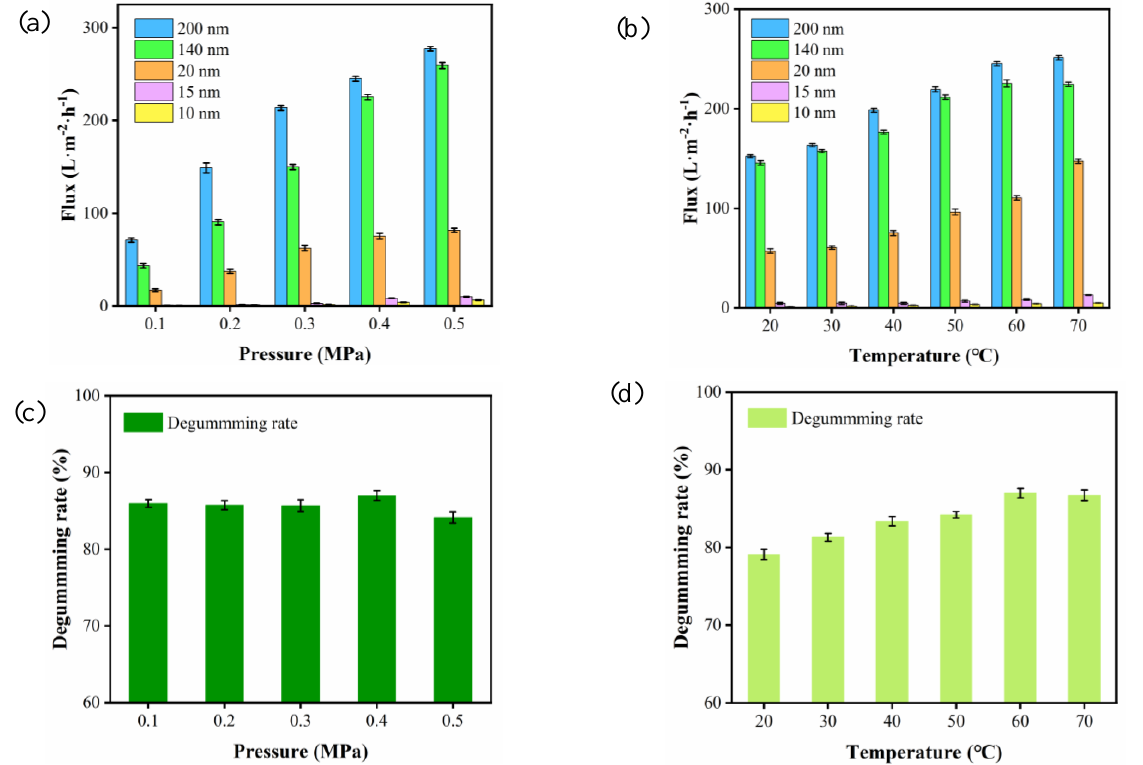
Figure 2. ( a ) Effect of different TMP on membrane fluxes at 60 °C. ( b ) Effect of different temperatures on membrane fluxes at 0.4 MPa. ( c ) Effect of different TMP on the degumming rate at 60 °C. ( d ) Effect of different temperatures on the degumming rate at 0.4 MPa.